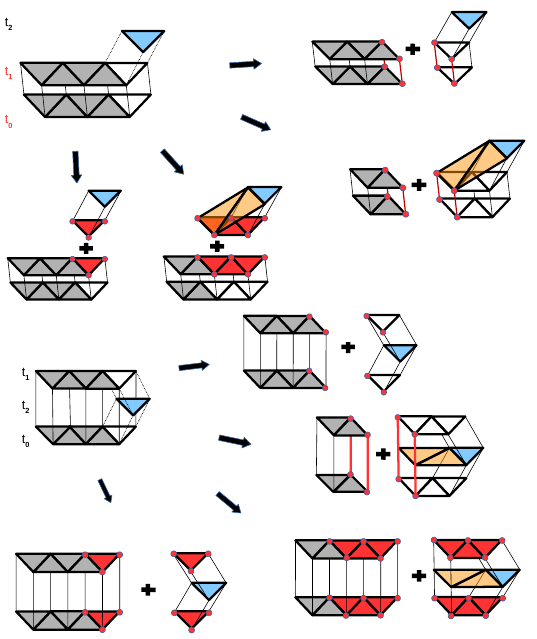
Figure 4. Split methods of a triangle-polytope complex when a triangle-polytope sequence is extended by a triangle-polytope.